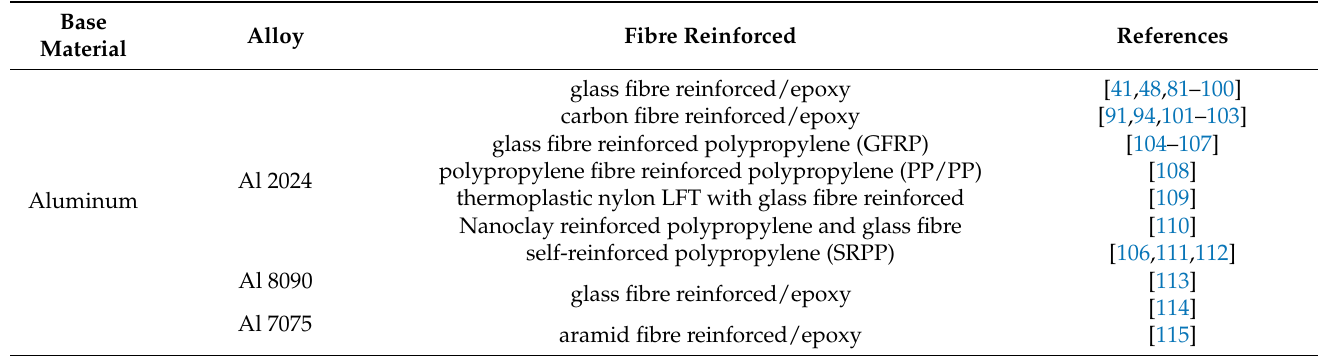
Table 1. Classifications of fibre–metal